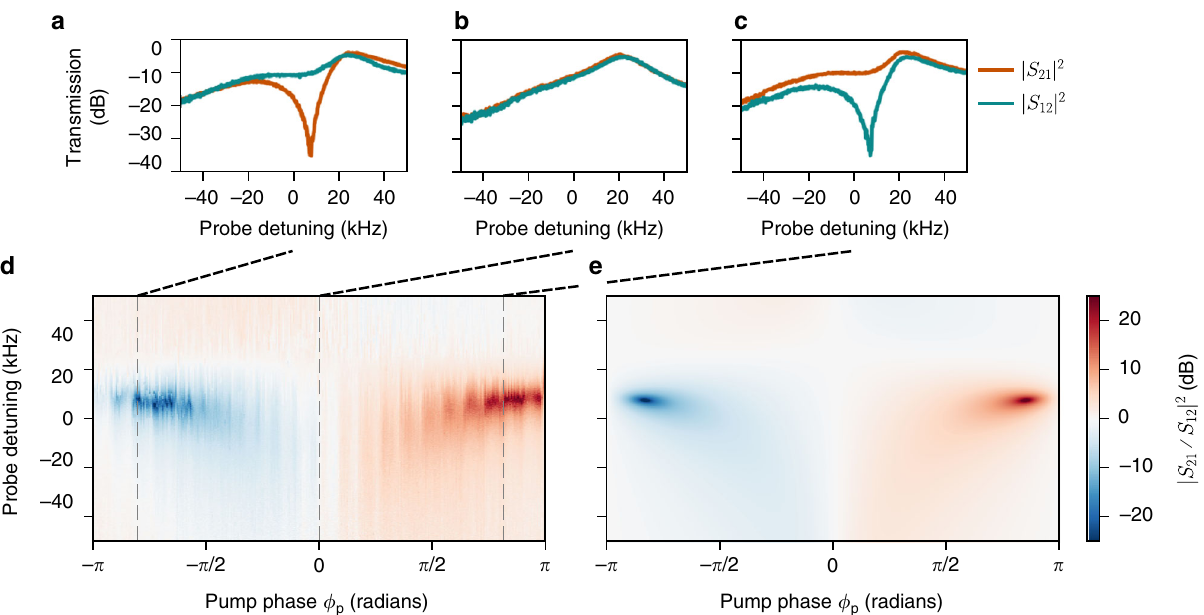
Fig. 3 Experimental demonstration of nonreciprocity. a – c Power transmission between modes 1 and 2 as a function of probe detuning, shown in both directions for pump phases ϕ p = − 0.8 π , 0, 0.8 π radians (respectively a – c ). Isolation of more than 20 dB in the forward c and backward a directions is demonstrated, as well as reciprocal behaviour b . d The ratio of transmission | S 21 / S 12 | 2 , representing a measure of nonreciprocity, is shown as a function of pump phase ϕ p and probe detuning. Two regions of nonreciprocity develop, with isolation in each direction. The system is recon fi gurable as the direction of isolation can be swapped by taking ϕ p → − ϕ p . e Theoretical ratio of transmission from Eq. (3), calculated with independently estimated experimental parameters. The theoretical model includes effectively lowered cooperativities for the mechanical mode ^ b 1 due to cross-damping (optomechanical damping of the lower frequency mechanical mode by the pump on the sideband of the higher frequency mechanical mode) acting as an extra loss channel